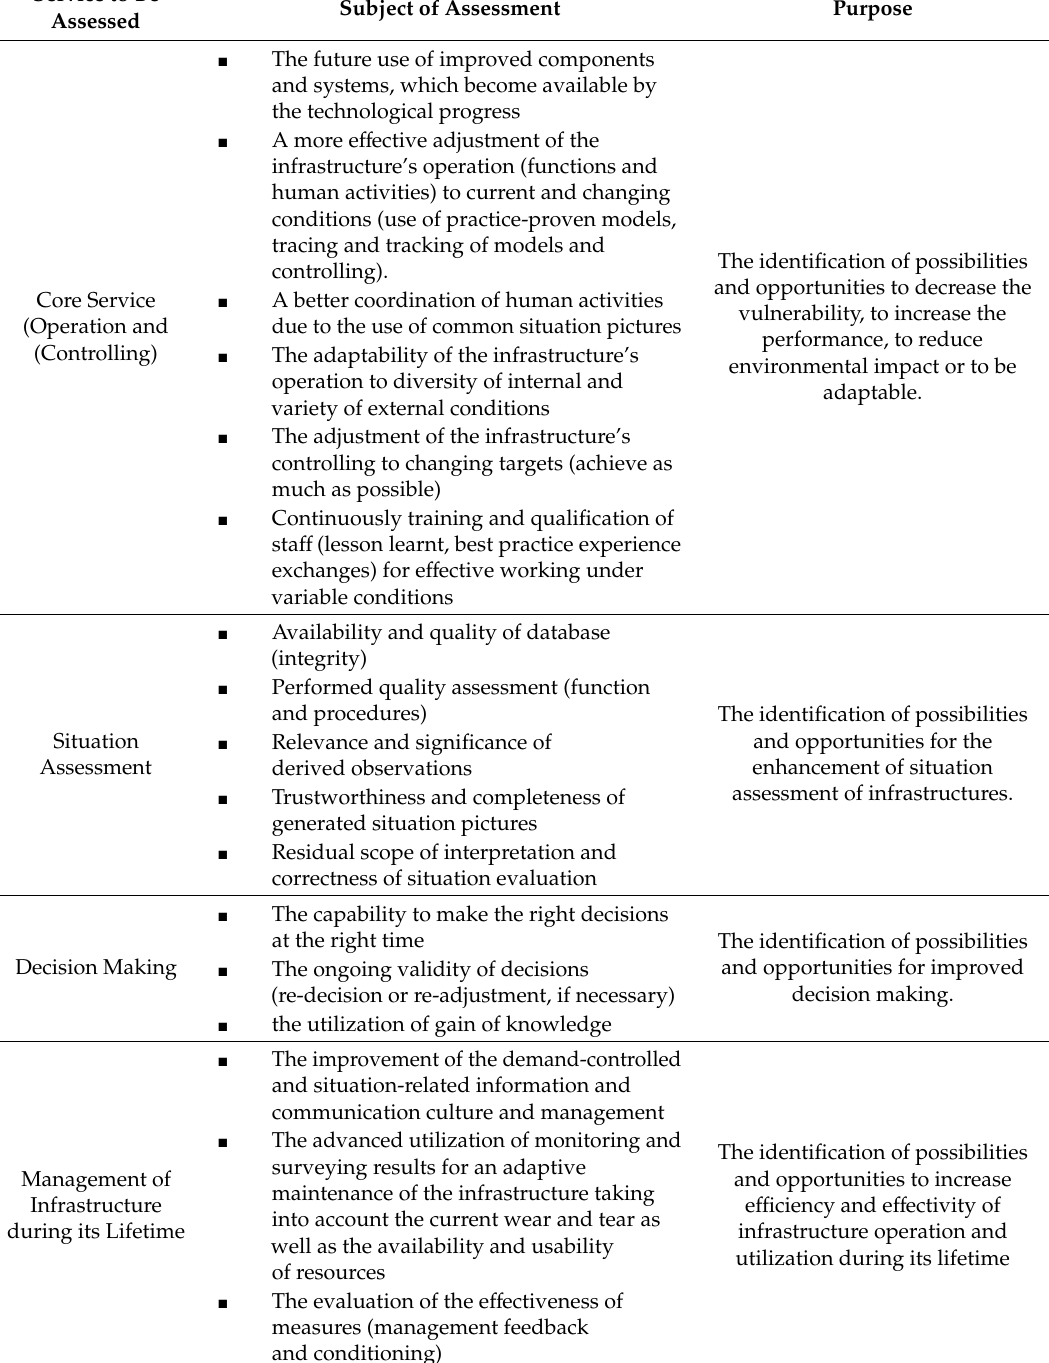
Table 4. Services to be assessed and subject of assessment, if “some things (may) go